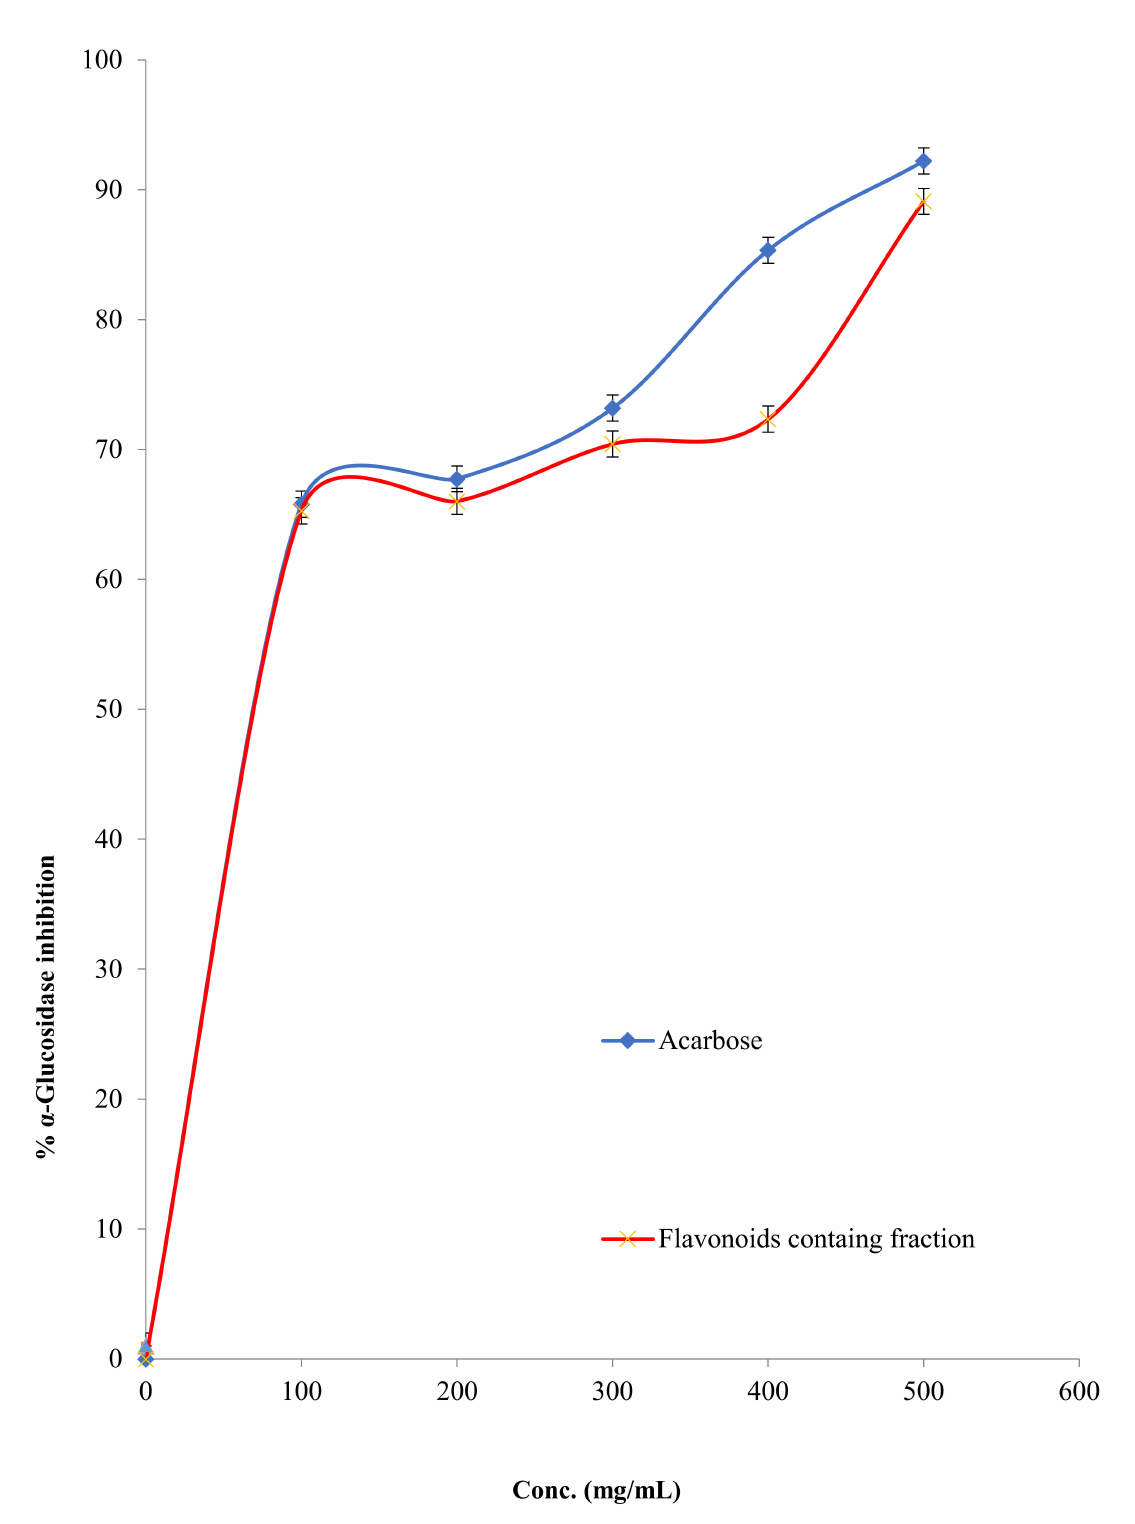
Figure 5. α -Glucosidase inhibition percentage of the FFM and